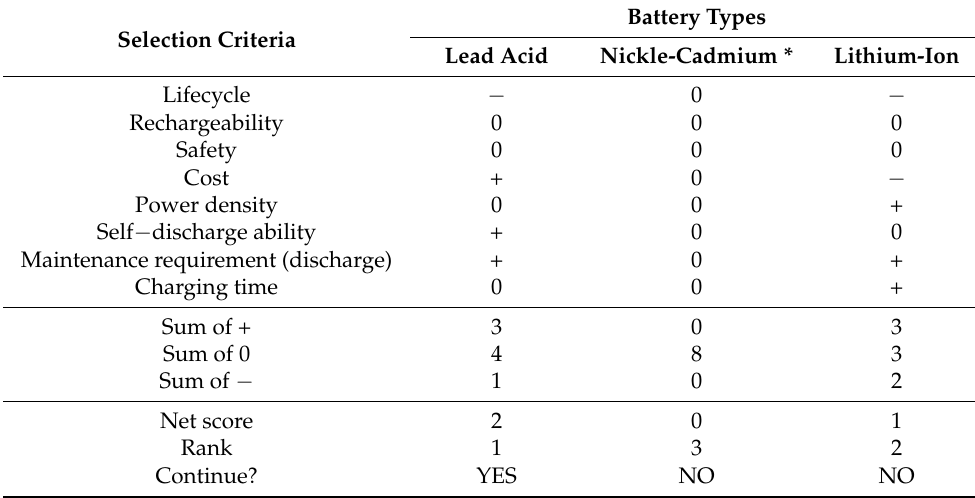
Table 6. Screening of battery